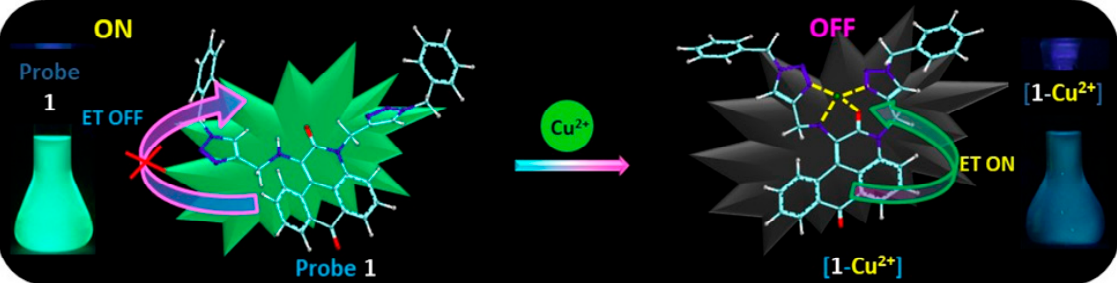
Figure 4. ( A ) Energy-minimized structures of probe 1 and [ 1 -Cu 2+ ]-complex (ball and wire model) and ( B ) electronic distributions and energies of their frontier molecular orbitals (FMOs; HOMOs and LUMOs) obtained from DFT calculations at the B3LYP/6-31G* level. Atoms are color-coded: N = blue, O = red, C = cyan, and H = grey.